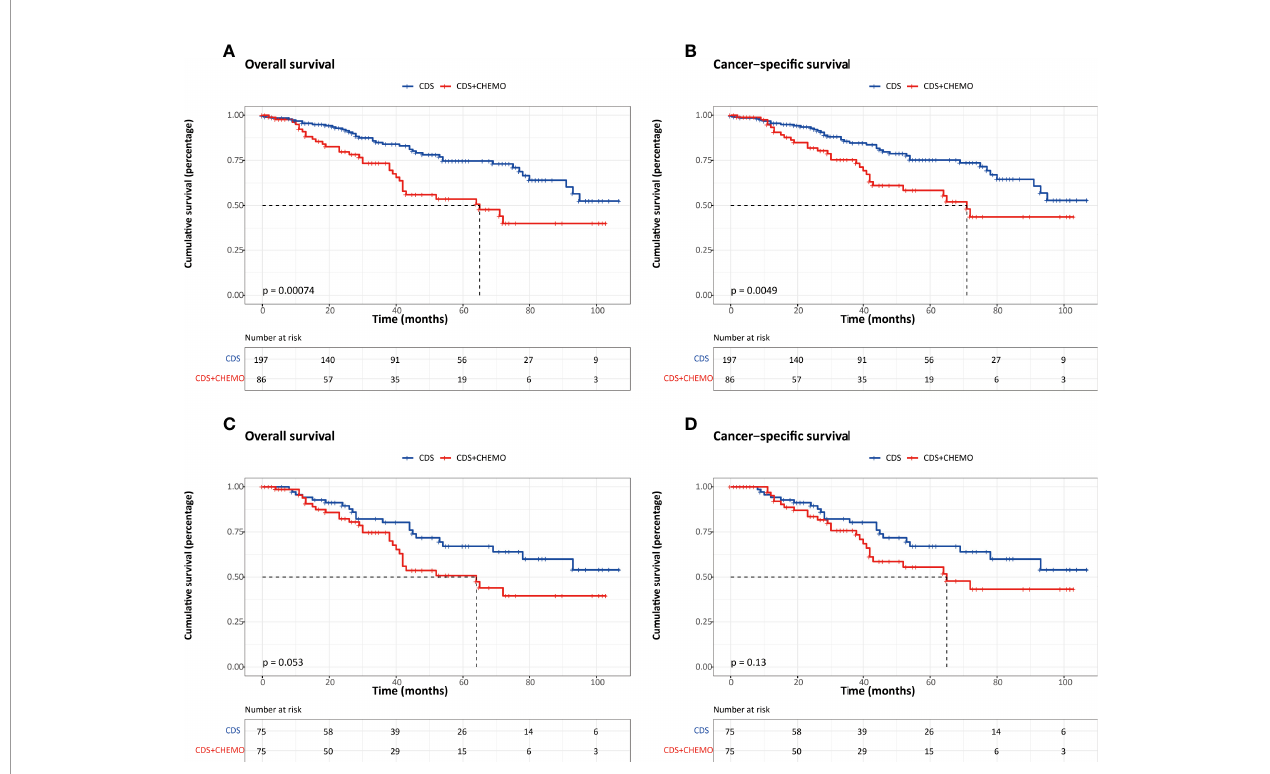
FIGURE 4 | Kaplan – Meier survival estimates between patients who underwent CDS and those who underwent CDS and chemotherapy. (A) Overall survival before PSM. (B) Cancer-speci fi c survival before PSM. (C) Overall survival after PSM. (D) Cancer-speci fi c survival after PSM. CDS, cancer-directed